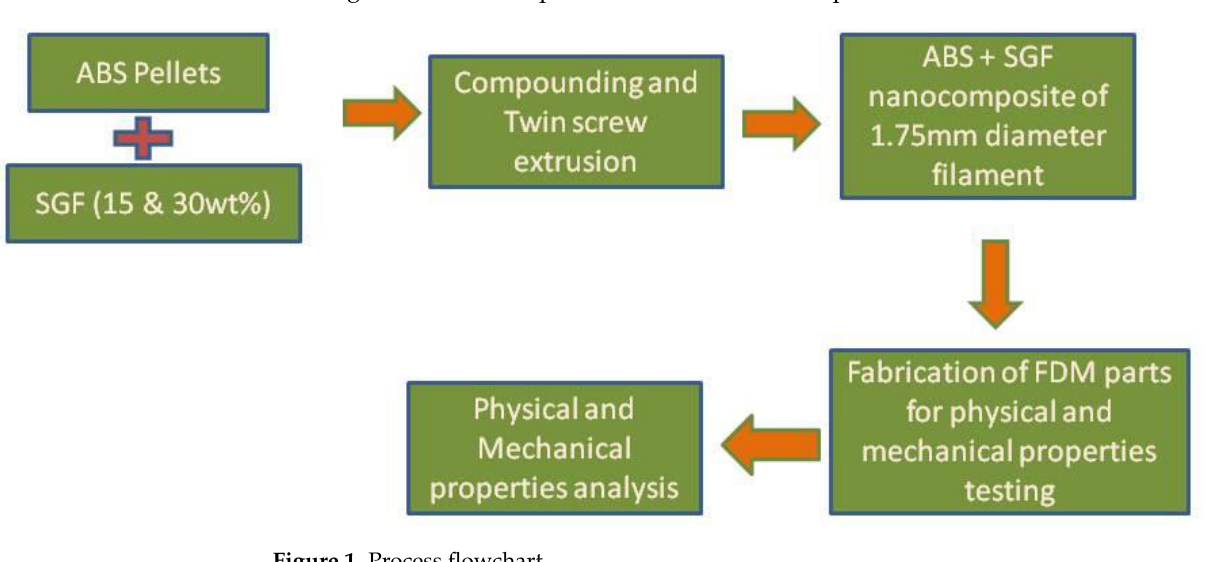
Figure 1. Process flowchart.